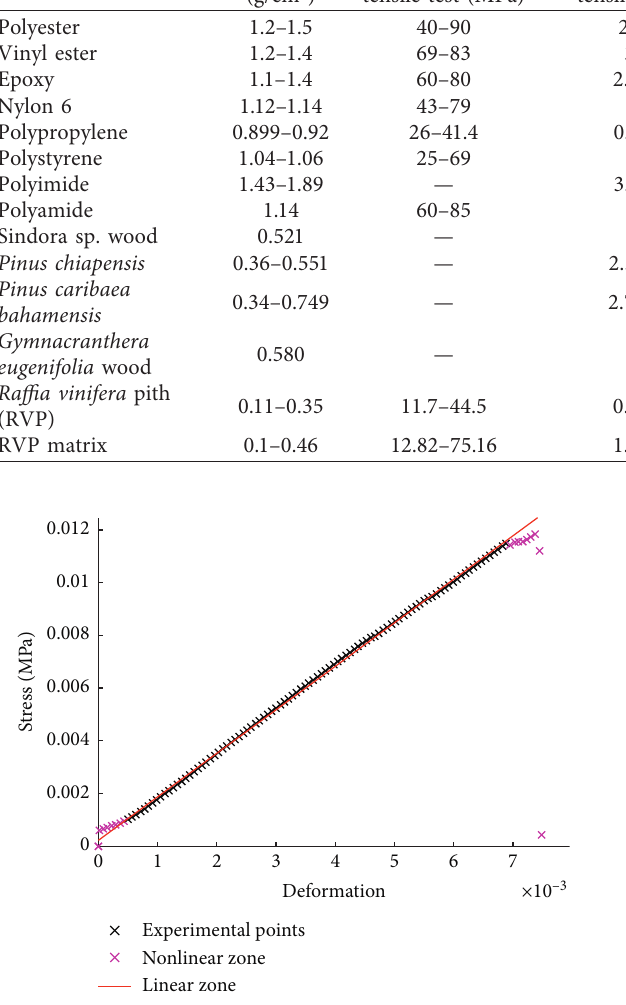
Figure 8: Curve of the stress as a function of the deformation of the specimen of the RVP of the zone (PL-1/4-R3) in the tensile